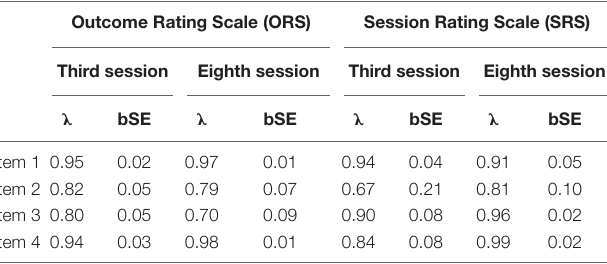
TABLE 3 | Factor loadings and standard errors of the Spanish versions of the Outcome Rating Scale (ORS) and the Session Rating Scale (SRS). Outcome Rating Scale (ORS)